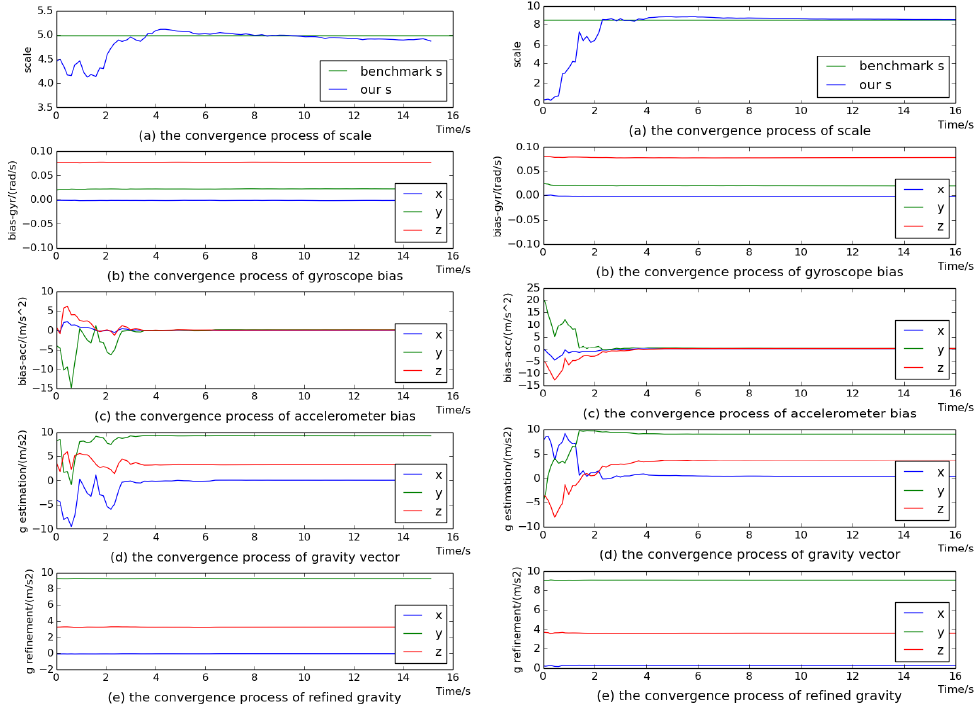
Figure 5. The convergence procedure of initial state on sequences MH_03_medium ( left ) and MH_04_difficult ( right